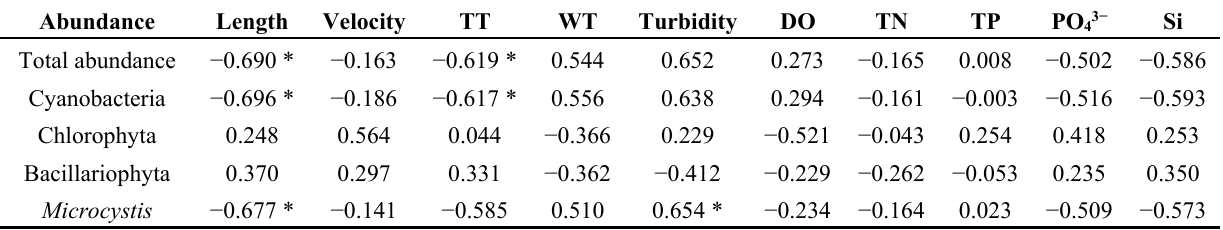
Table 3. Pearson correlation coefficients between variables and phytoplankton abundances in September